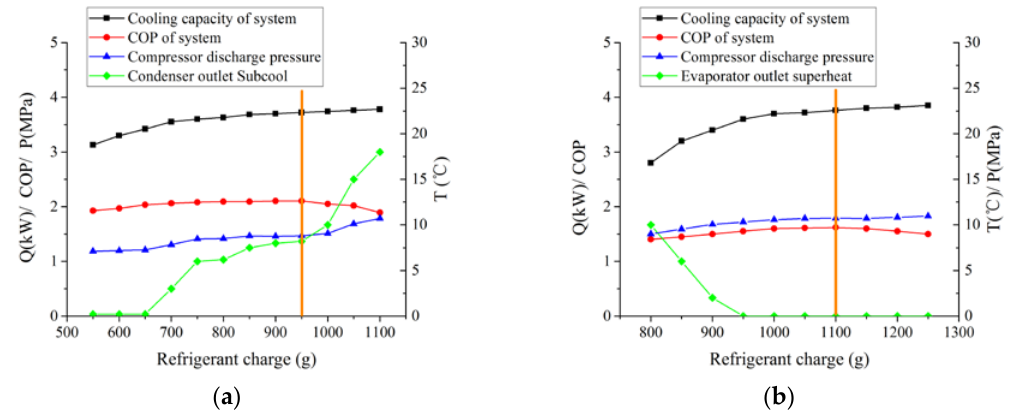
Figure 3. System characteristics with varied refrigerant charge for ( a ) R134a system ( b ) CO 2 system.